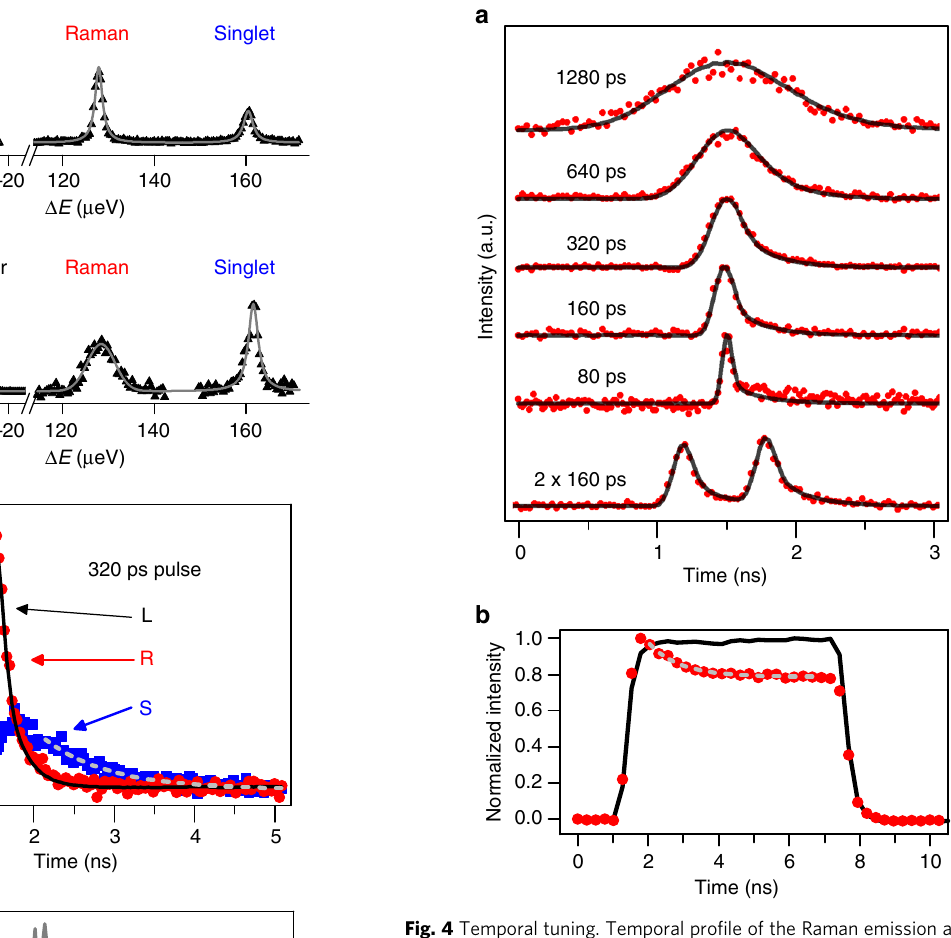
should modify the temporal behavior of pulsed Raman.